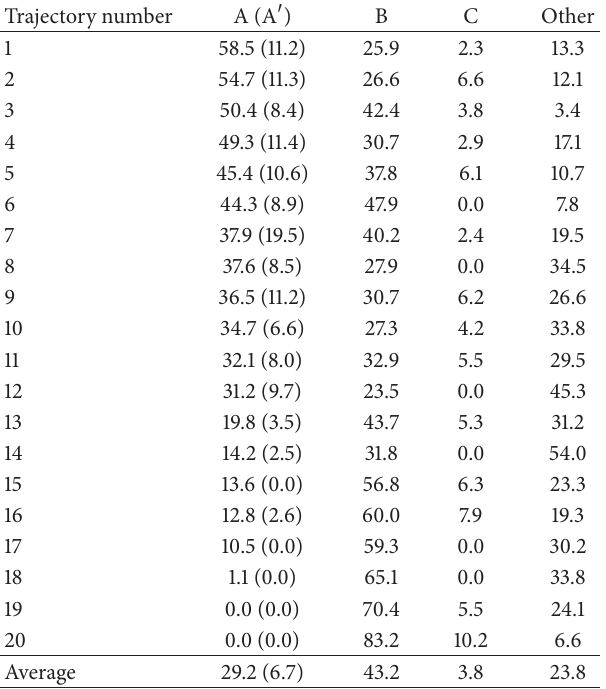
Table 1: Existence ratios (%) of representative structures of chigno- lin obtained by the SAAP-MC simulation at 300 K in water.